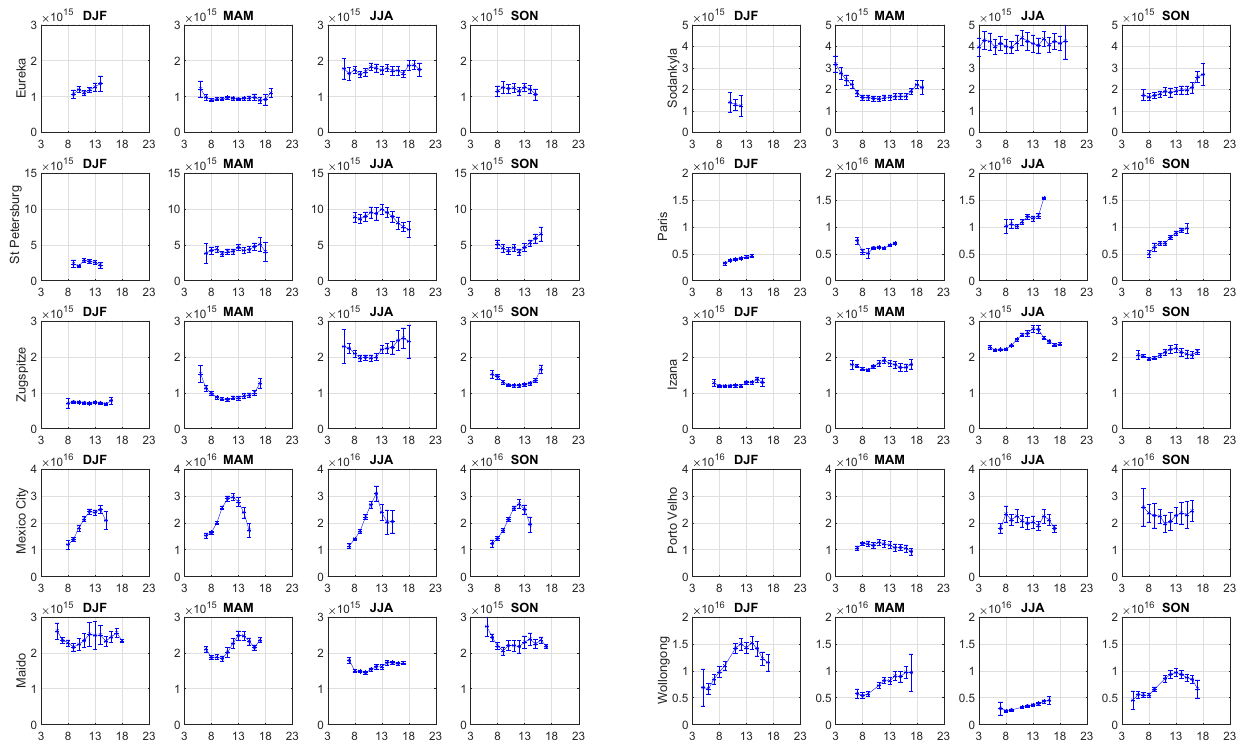
Figure 6. Diurnal cycles of HCHO total columns (moleccm − 2 ) at selected stations for the four seasons. The diurnal cycles for the other stations are shown in the Supplement (Fig. S2). The error bars are the standard errors of the mean: 2 × σ/ and n the number of measurements at a given time. If n < 8, the hourly value is not shown. The time is the local standard time meridian